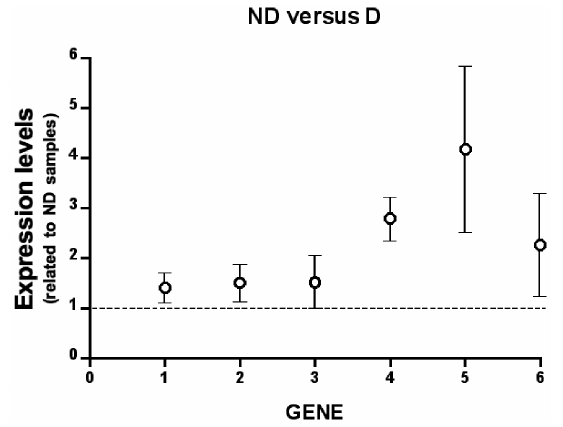
Fig. 2 – Comparison of the expression levels of the tested genes be- tween health and dengue virus infected samples. A pool of sixteen (8 DF/DFC plus 8 DHF) dengue samples and a pool of five non- dengue (ND) samples were used to extract mRNA. The amount of mRNA of each tested gene was measured by qPCR assays. Expression levels of tested genes are related to ND samples. All samples were tested in